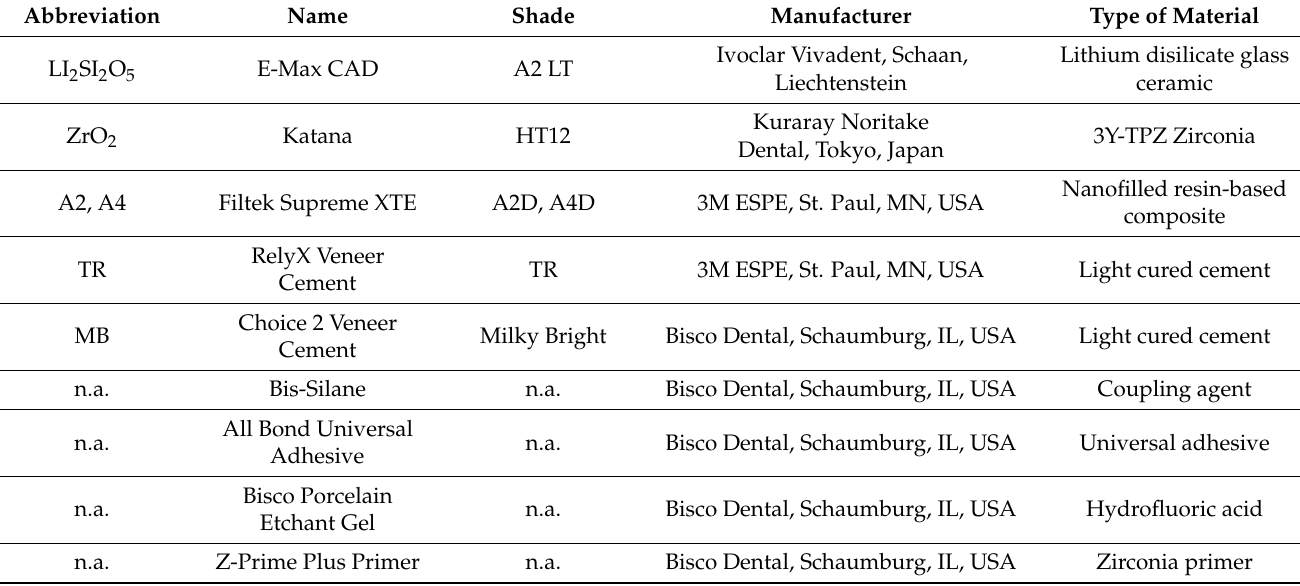
Table 1. Materials used in present